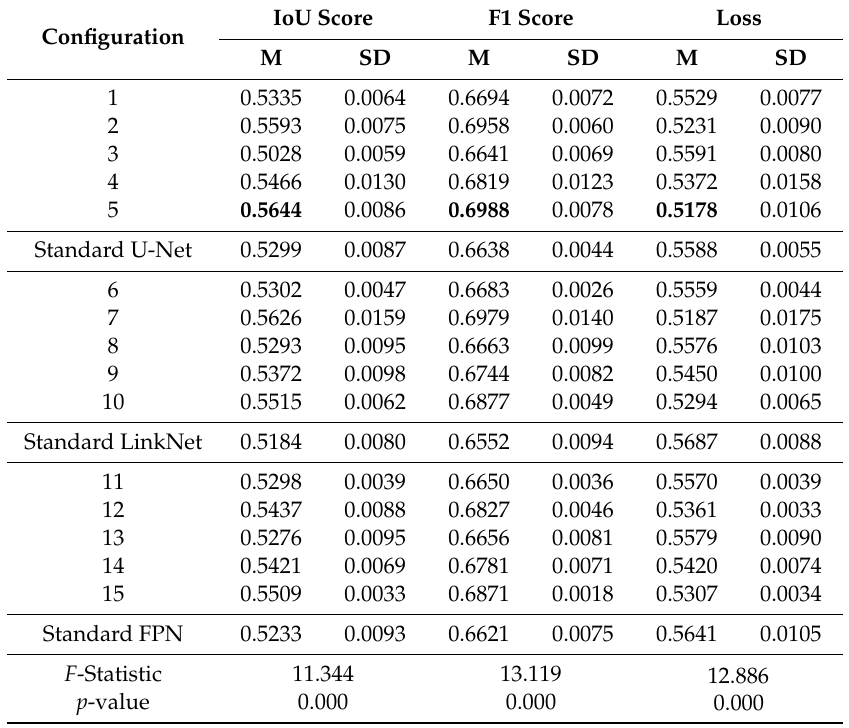
Table 1. Mean (M) and standard deviation (SD) of the performance metrics (IoU score, F1 score and Loss) obtained by the